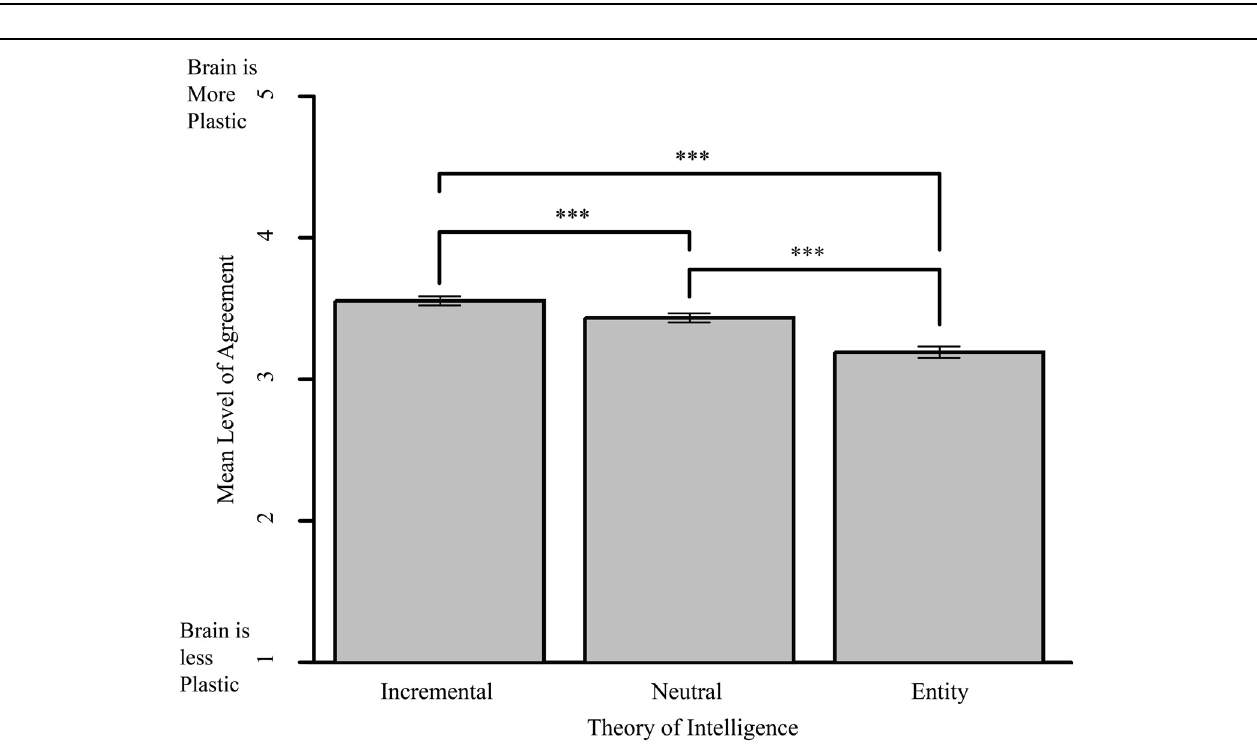
FIGURE 2 | Theories of intelligence and beliefs about brain plasticity. Mean level of agreement with statements such as “There is a lasting change in a person’s brain after he or she learns a new language,” by participants in the different TOI groups. Error bars indicate SE. ∗∗∗ p < 0.001.